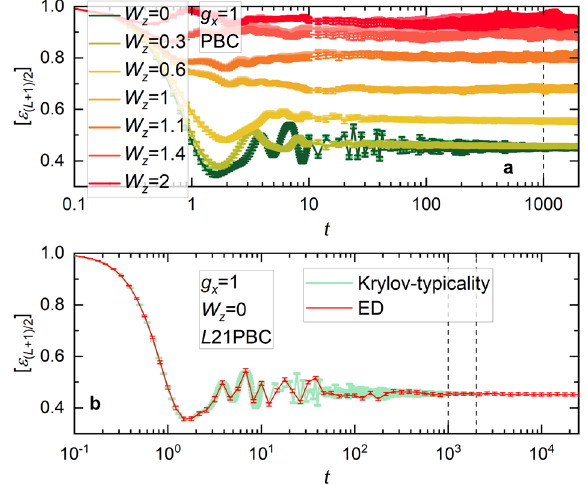
Fig. 9 Longer-chain results. a Time evolution of return probability as a function of W z at fi xed g x = 1 obtained by applying the Krylov- typicality method to periodic chains. The light to solid colors give the results of L = 21, 23, 25. b A sample calculation on a small chain illustrates that Krylov-typicality approximation reproduces the results of